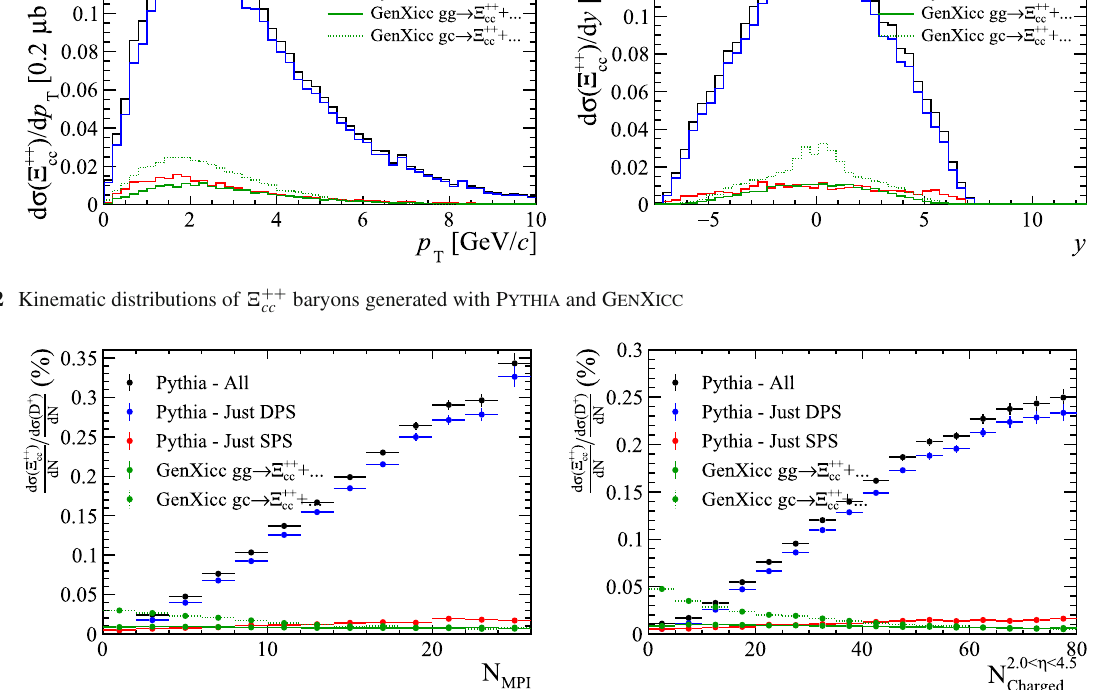
baryons generated with Pythia and GenXicc bc